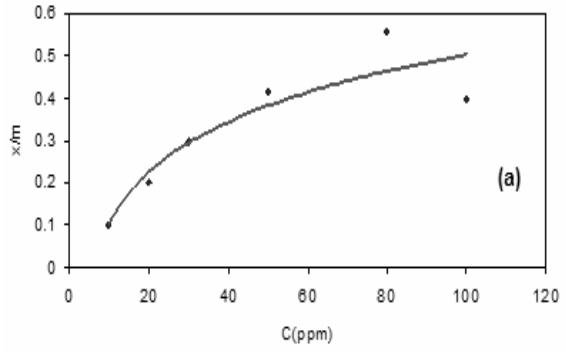
Figure. 8 Effect of initial Hg 2+ ion concentration on sorption by PANi/SD